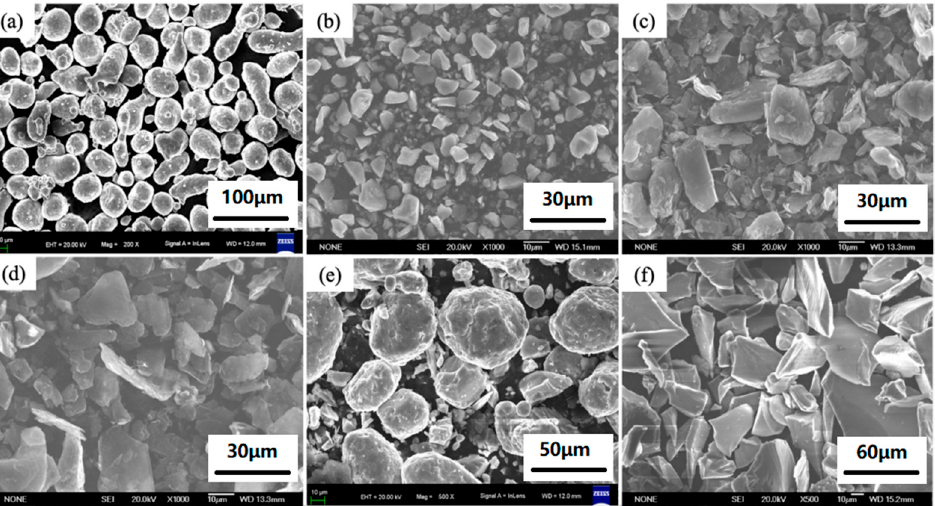
Figure 1. SEM images of the raw materials: ( a ) raw Al, ( b ) raw Si, ( c ) raw graphite 1 (G1), ( d ) raw graphite 2 (G2), ( e ) Al-Si-C premixed powder, and ( f ) ex situ SiC powder.